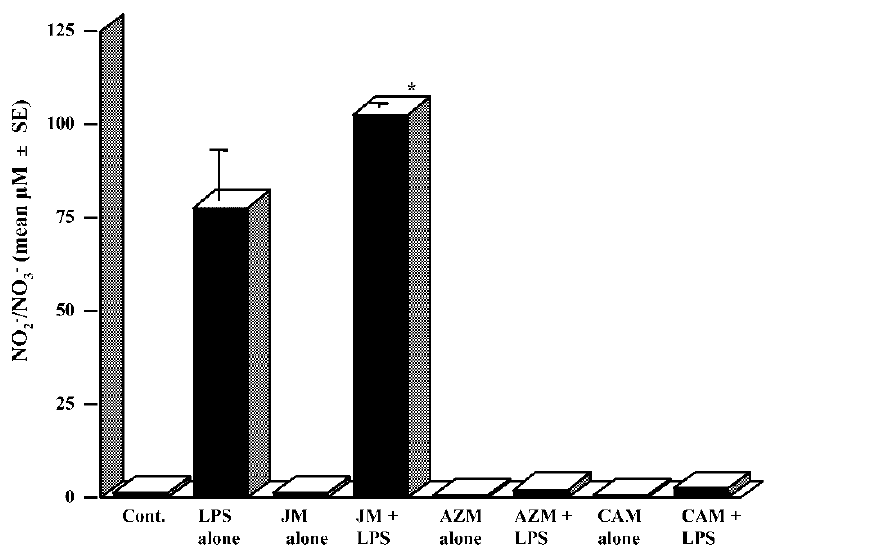
FIG. 4. Influence of several types of macrolide antibiotics on NO (NO 2 (cid:1) /NO 3 (cid:1) ) generation in response to LPS injection.ICR mice were administered orally with either JM, AZM, or CAM once a day for 4 weeks. The mice were then injected intraperitoneally with 5.0 mg/kg of LPS, and plasma NO 2 (cid:1) /NO 3 (cid:1) levels were examined 6 h later. The data are expressed as the mean ( m M) 9 / standard error of five mice. * Not significant compared with LPS